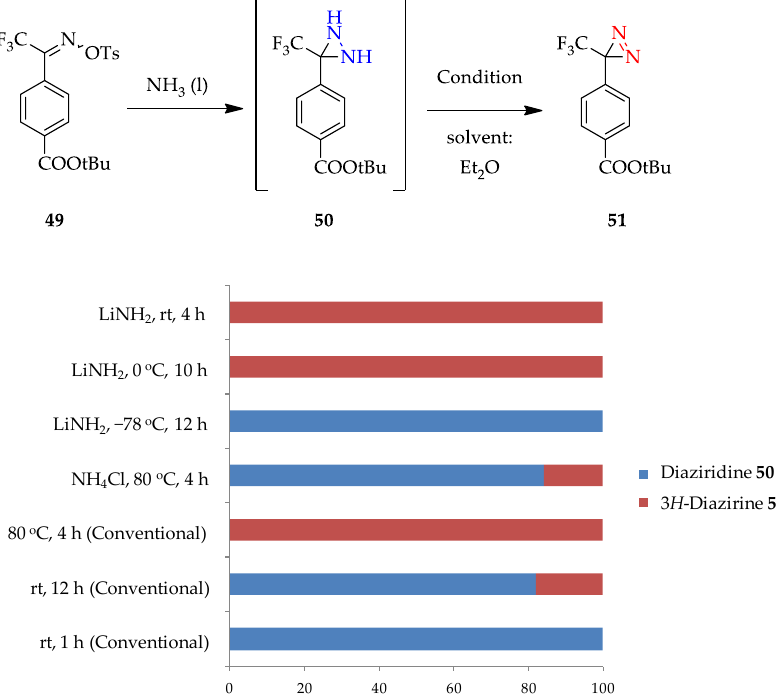
Figure 6. Diaziridine 50 formation in one-pot approaches for synthesis of 3-phenyl-3-(trifluoromethyl)-3 H -diazirine (51, TPD) from tosyloxime 49 .